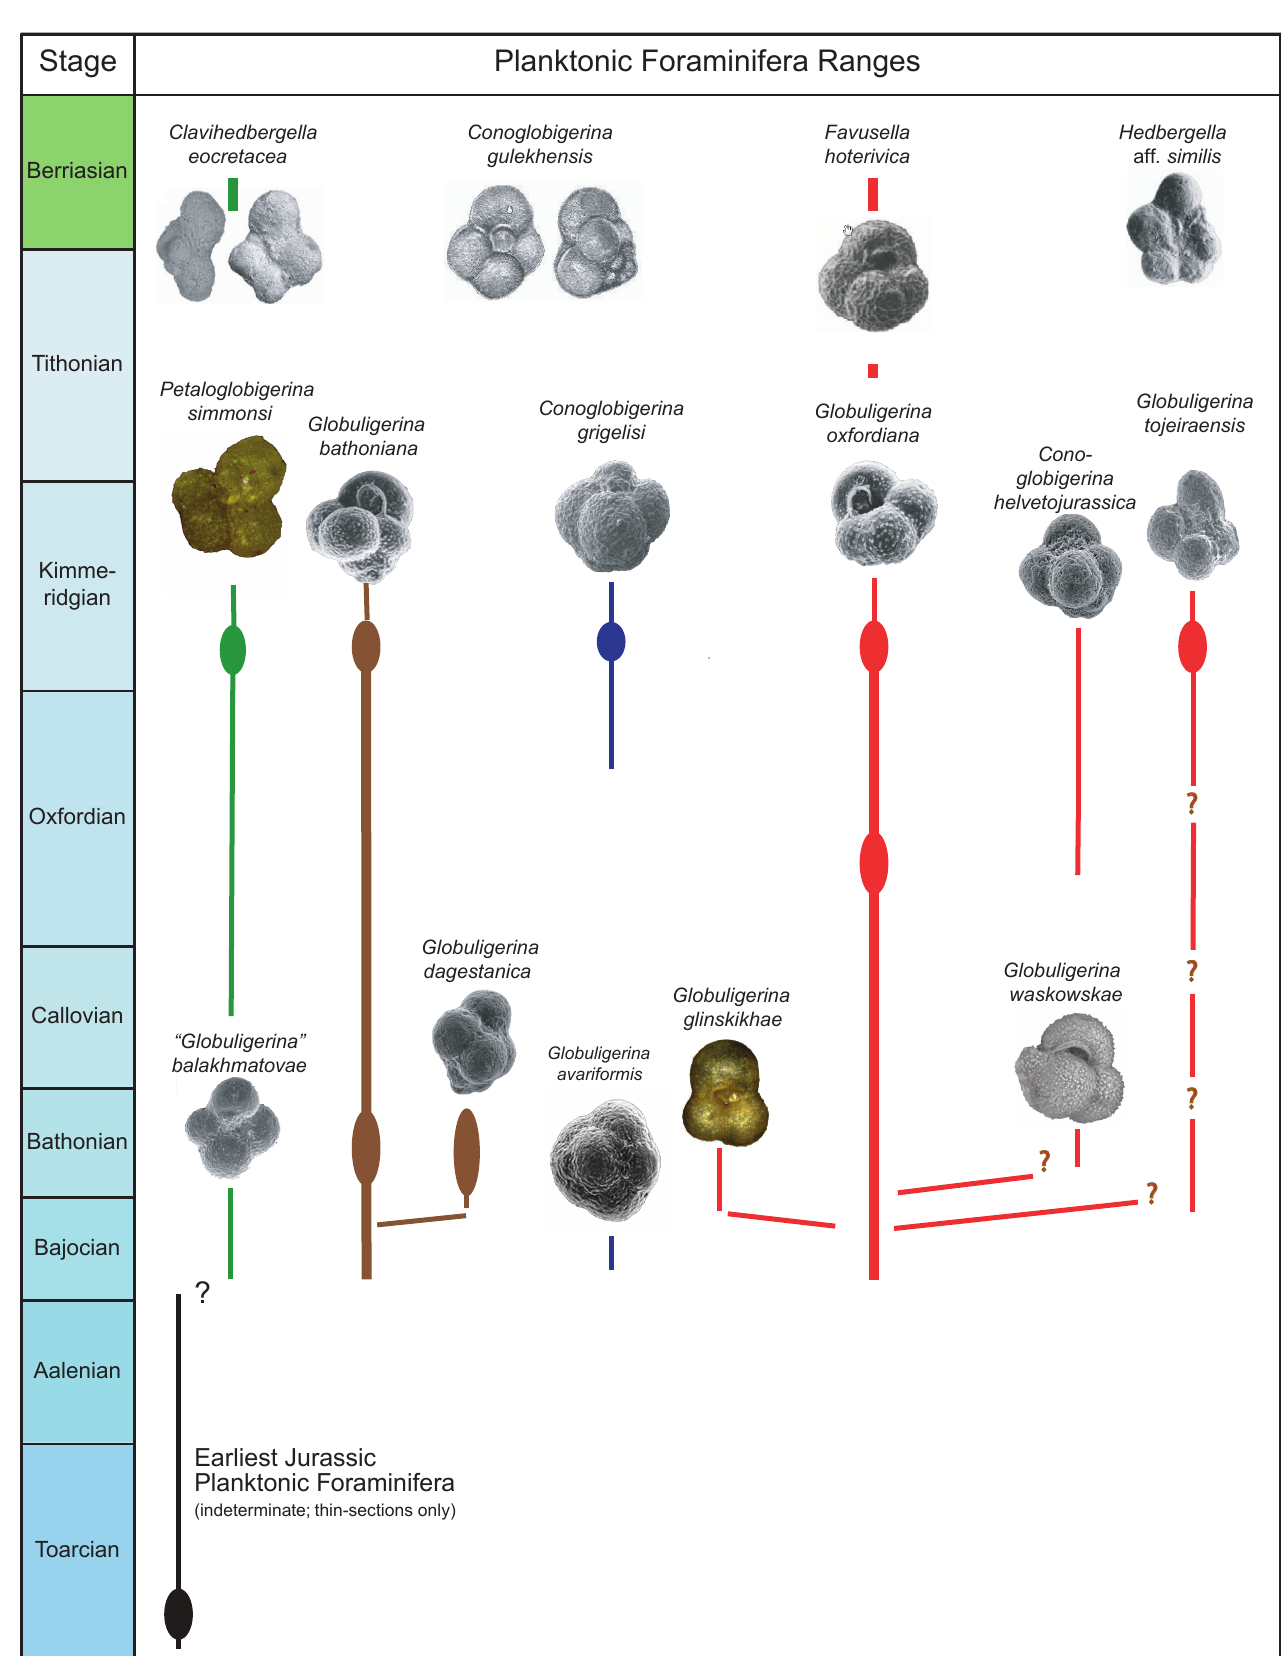
Figure 5. Stratigraphic ranges and evolution of Jurassic planktonic foraminifera. For details, see